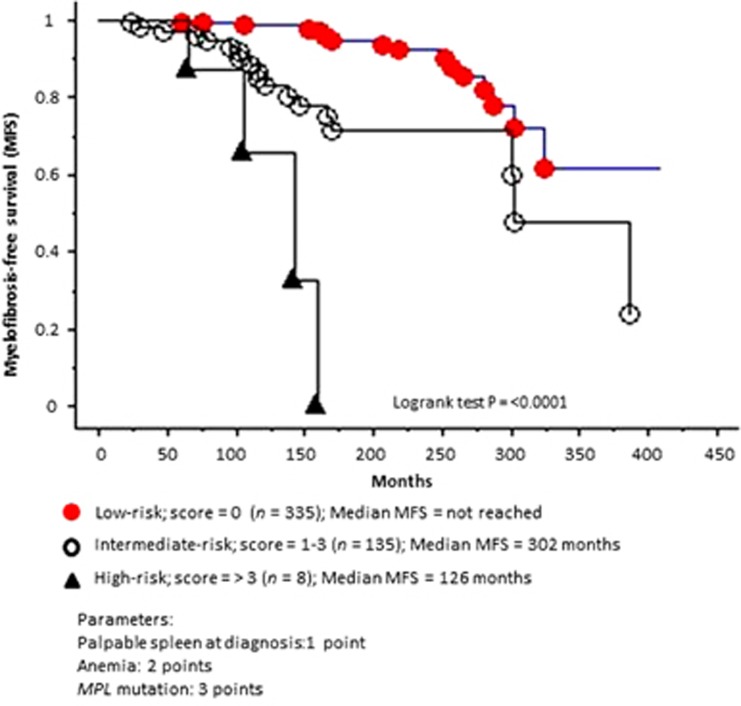
Myelofibrosis-free survival among 478 patients with essential thrombocythemia stratified into risk groups.